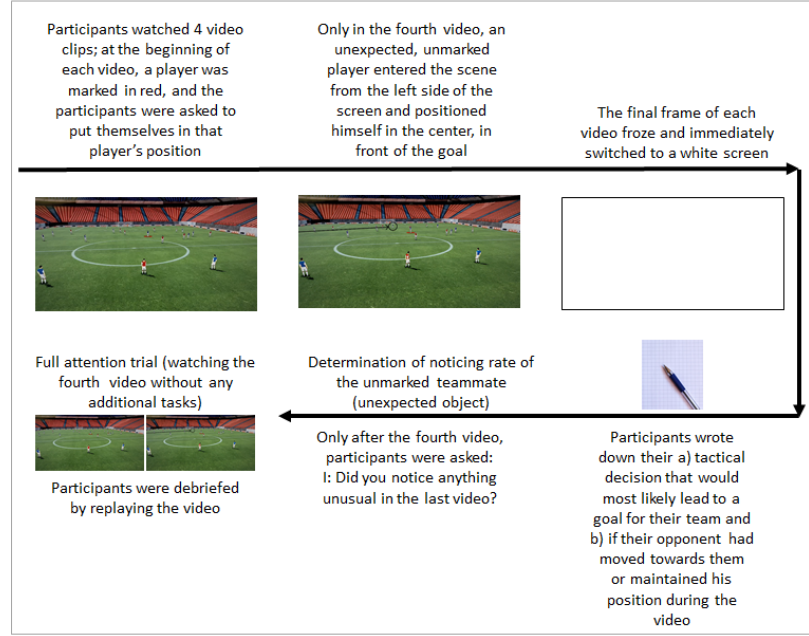
Figure 3. A flow chart demonstrating the procedure of Experiment